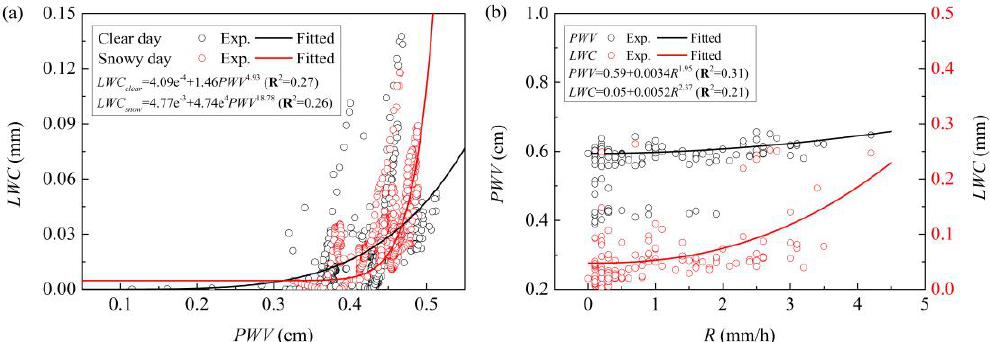
Figure 12. Scattergrams of LWC against PWV ( a ) and PWV (and LWC ) against R ( b ) for snowy days.